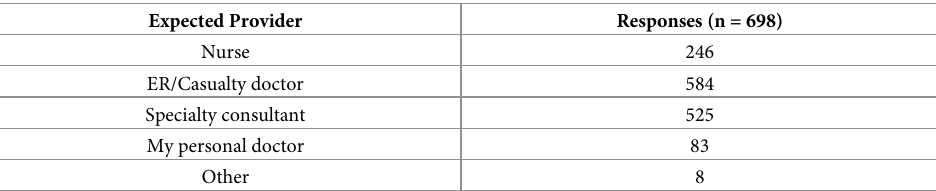
Table 9. Expected provider in the